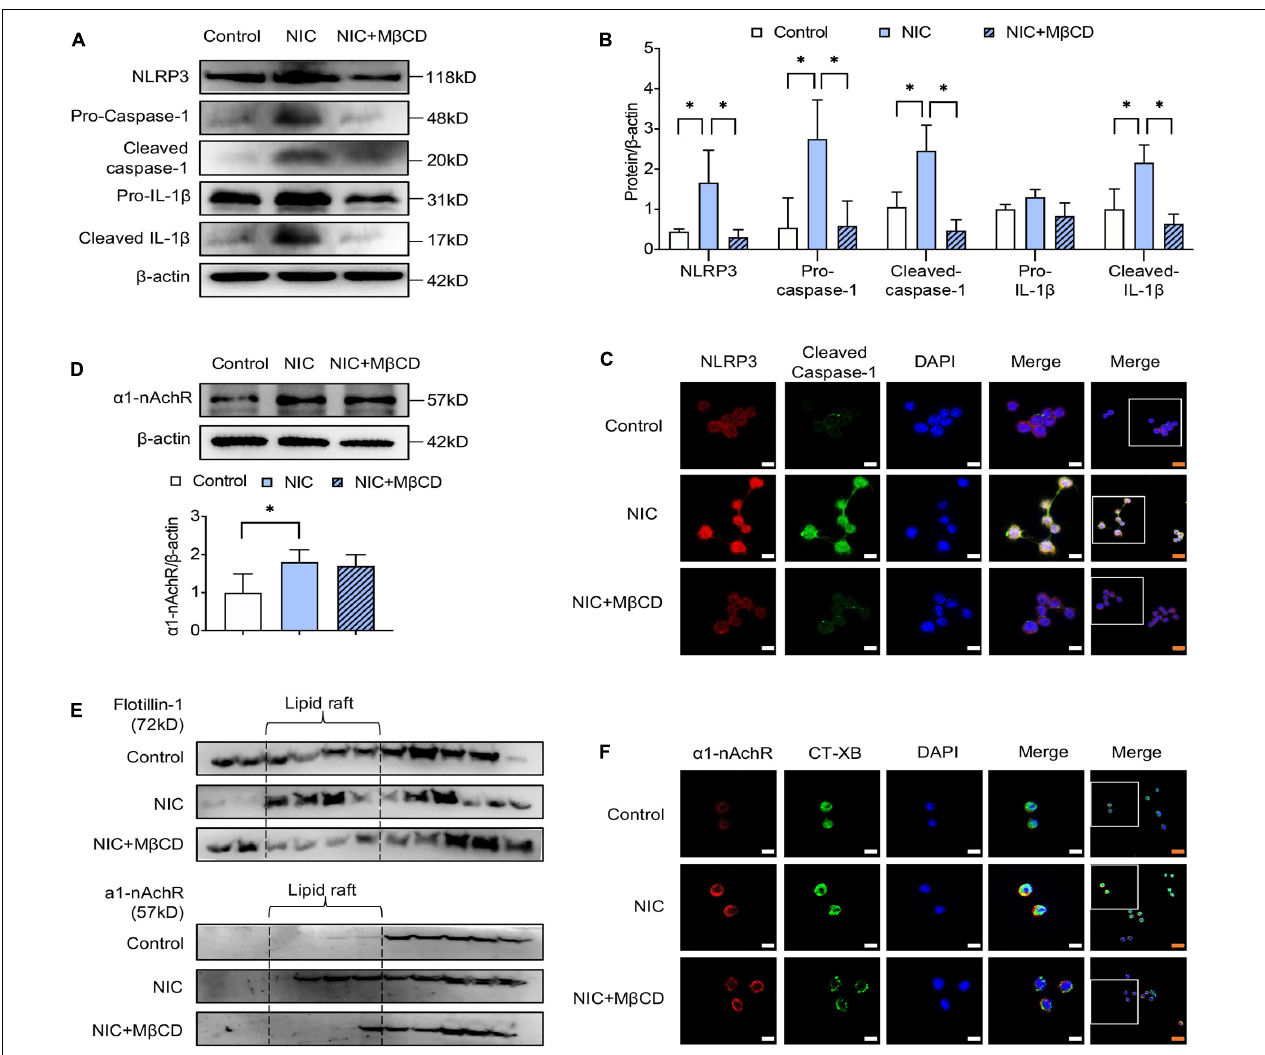
FIGURE 2 | Lipid raft disruptor prevented nicotine-induced NLRP3 inflammasome activation in macrophage by inhibiting a1-nAchR accumulation into lipid raft. M β CD was used as the standard lipid raft disruptor. (A,B) The protein expression and quantitative analysis of NLRP3, pro- and cleaved caspase-1 and IL-1 β . (C) Immunofluorescence showing colocalization of cleaved caspase-1 (green) with NLRP3 (red) in macrophage. (D) The protein expression and quantitative analysis of a1-nAchR. (E) Immunofluorescence showing colocalization of a1-nAchR (red) and CT-XB (lipid raft marker) (green) in macrophage. (F) The protein expression of a1-nAchR and flotillin-1 in lipid raft, n = 3. White bars = 5 µ m, orange bars = 10 µ m. All data are represented as mean ± SD of three independent experiments. ANOVA test followed by Holm–Šídák post-hoc test was used for statistical analysis. ∗ p < 0.05. NIC, nicotine; NLRP3, Nod-like receptor protein 3; M β CD, methyl- β